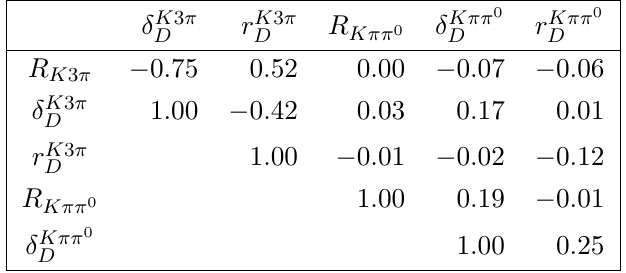
Table 20 . Correlation matrix for the hadronic parameters from the global fit to the BESIII, CLEO- c and LHCb